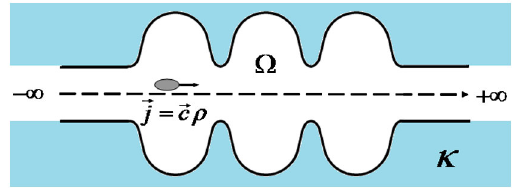
FIG. 1. Charged particle bunch moving through an accelerat- ing structure supplied with infinite pipes.